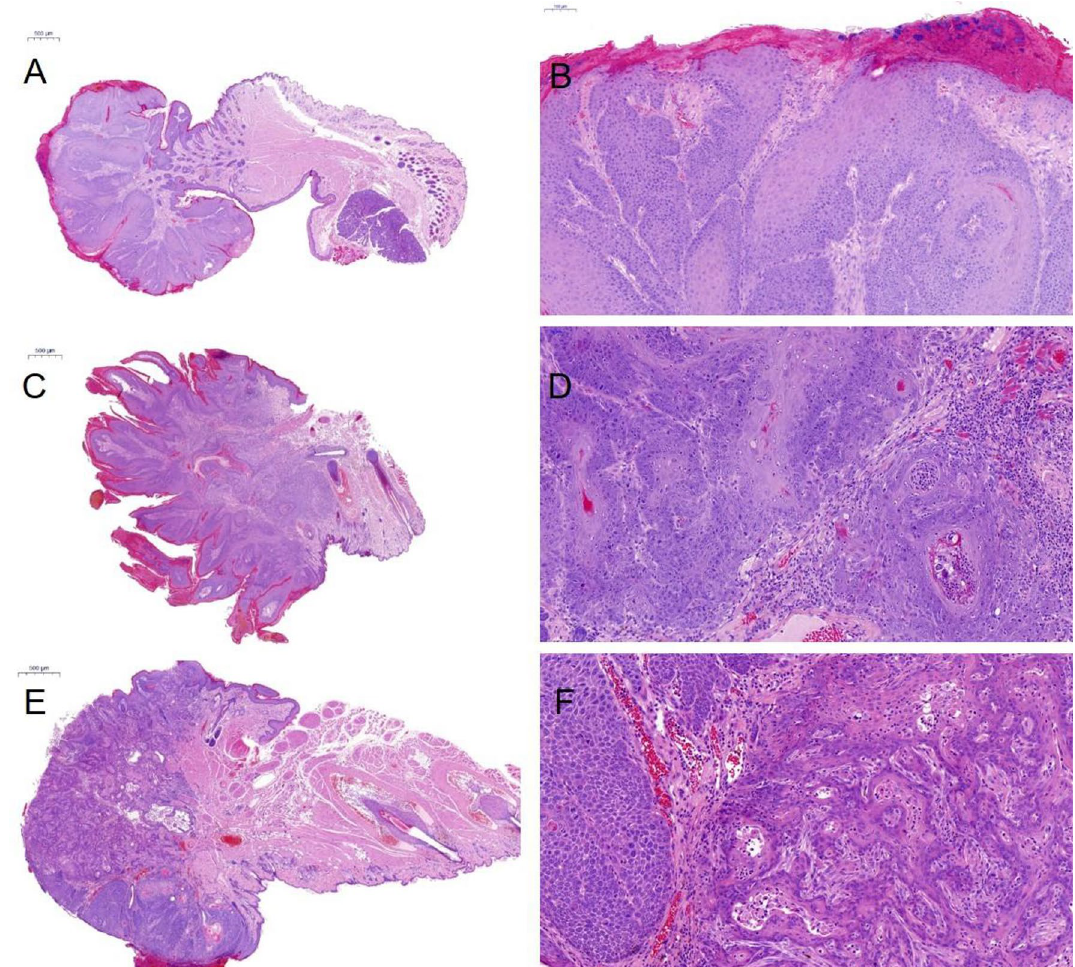
Figure 4. Representative histological analysis of squamous cell carcinoma (SCC) formation in the mucosa. Haematoxylin–eosin staining of squamous cell carcinoma (SCC) of the oral mucosa of mice [( A , B ): MWM + high dose dibenzo(a)pyrene (DBP); ( C , D ) ultraviolet (UV) 48 s + high dose DBP; ( E , F ): kINPen 10 s + high dose DBP]. SCCs showed an endophytic and plump invasive growth pattern with mostly mild to moderate